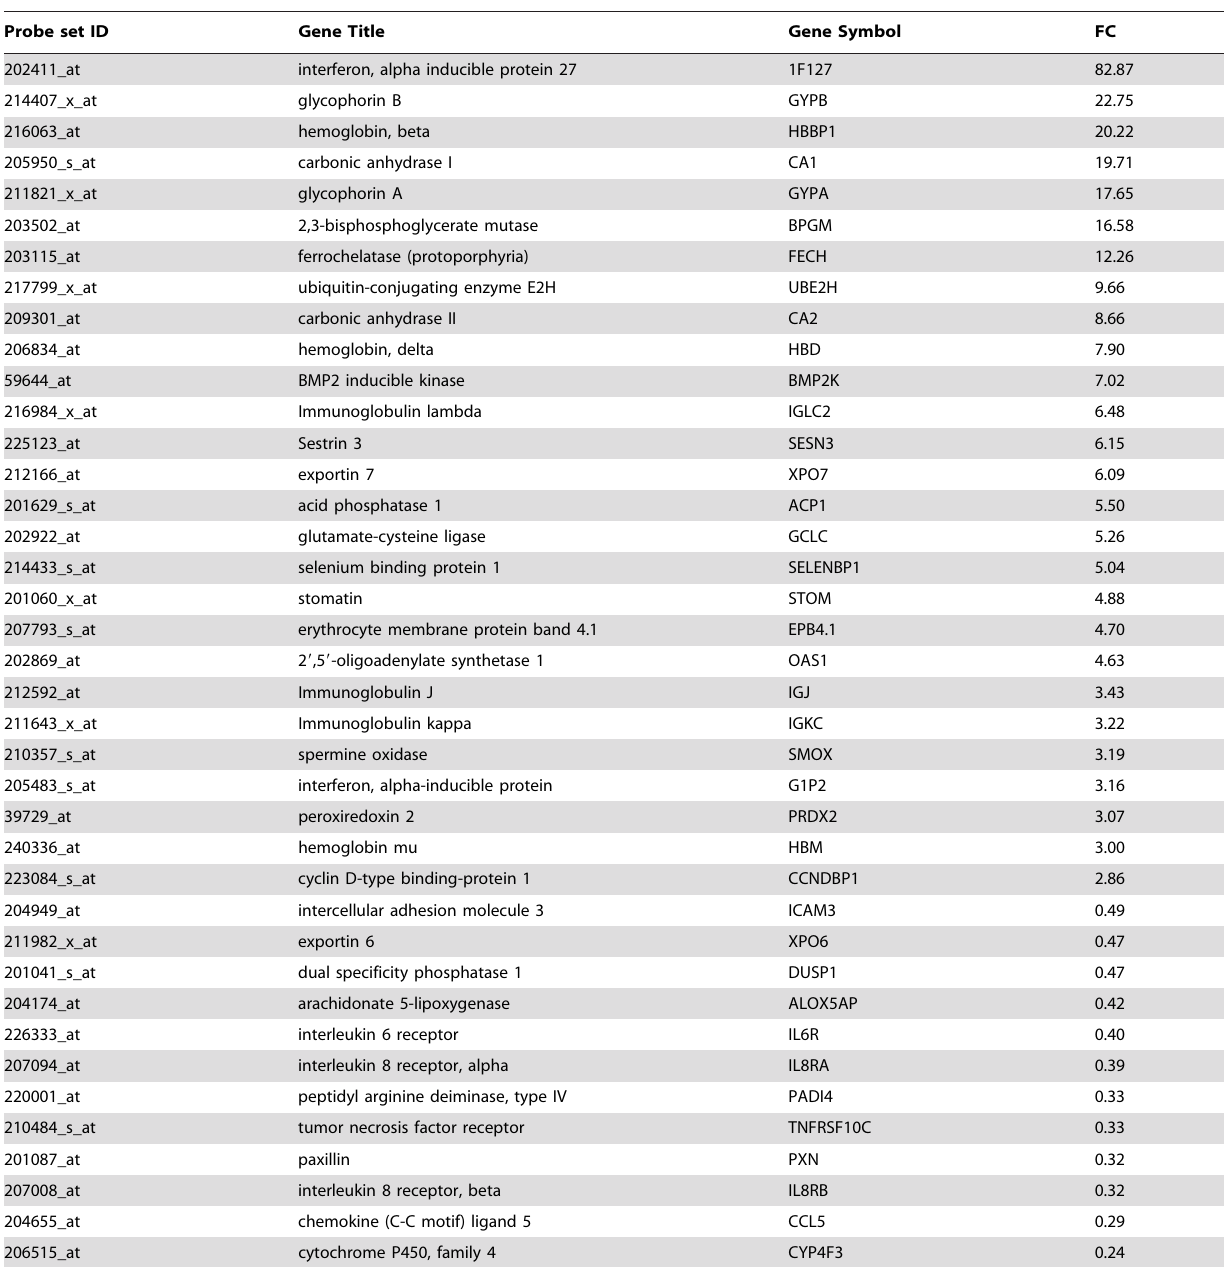
Table 3. List of differentially regulated genes in SCD from